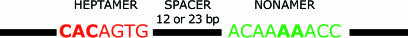
RSSs Consist of a Fairly Conserved Heptamer and Nonamer Sequence, Separated by a Spacer ElementHeptamer is shown in red and nonamer in green. Conserved nucleotides are shown in bold. The spacer is either 12 or 23 bp long.